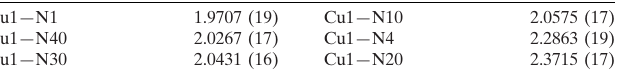
Selected bond lengths (A˚ ).